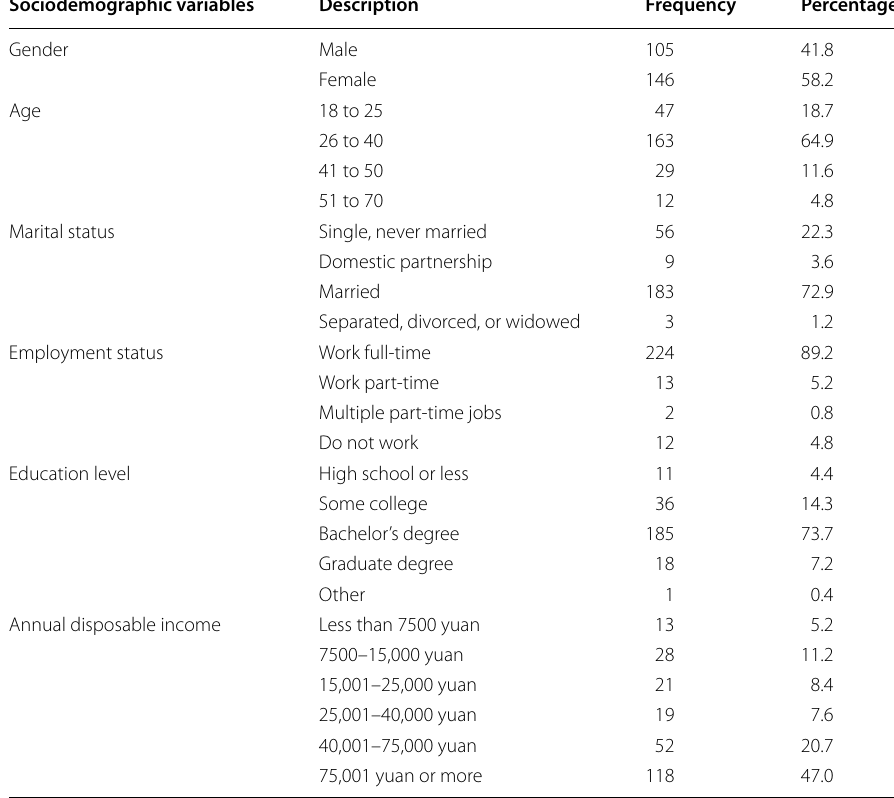
Table 2 Summary of the respondents’ sociodemographic profiles ( n